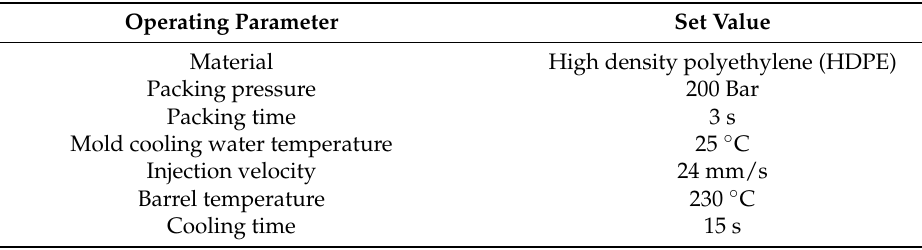
Table 2. Operating condition settings for injection molding